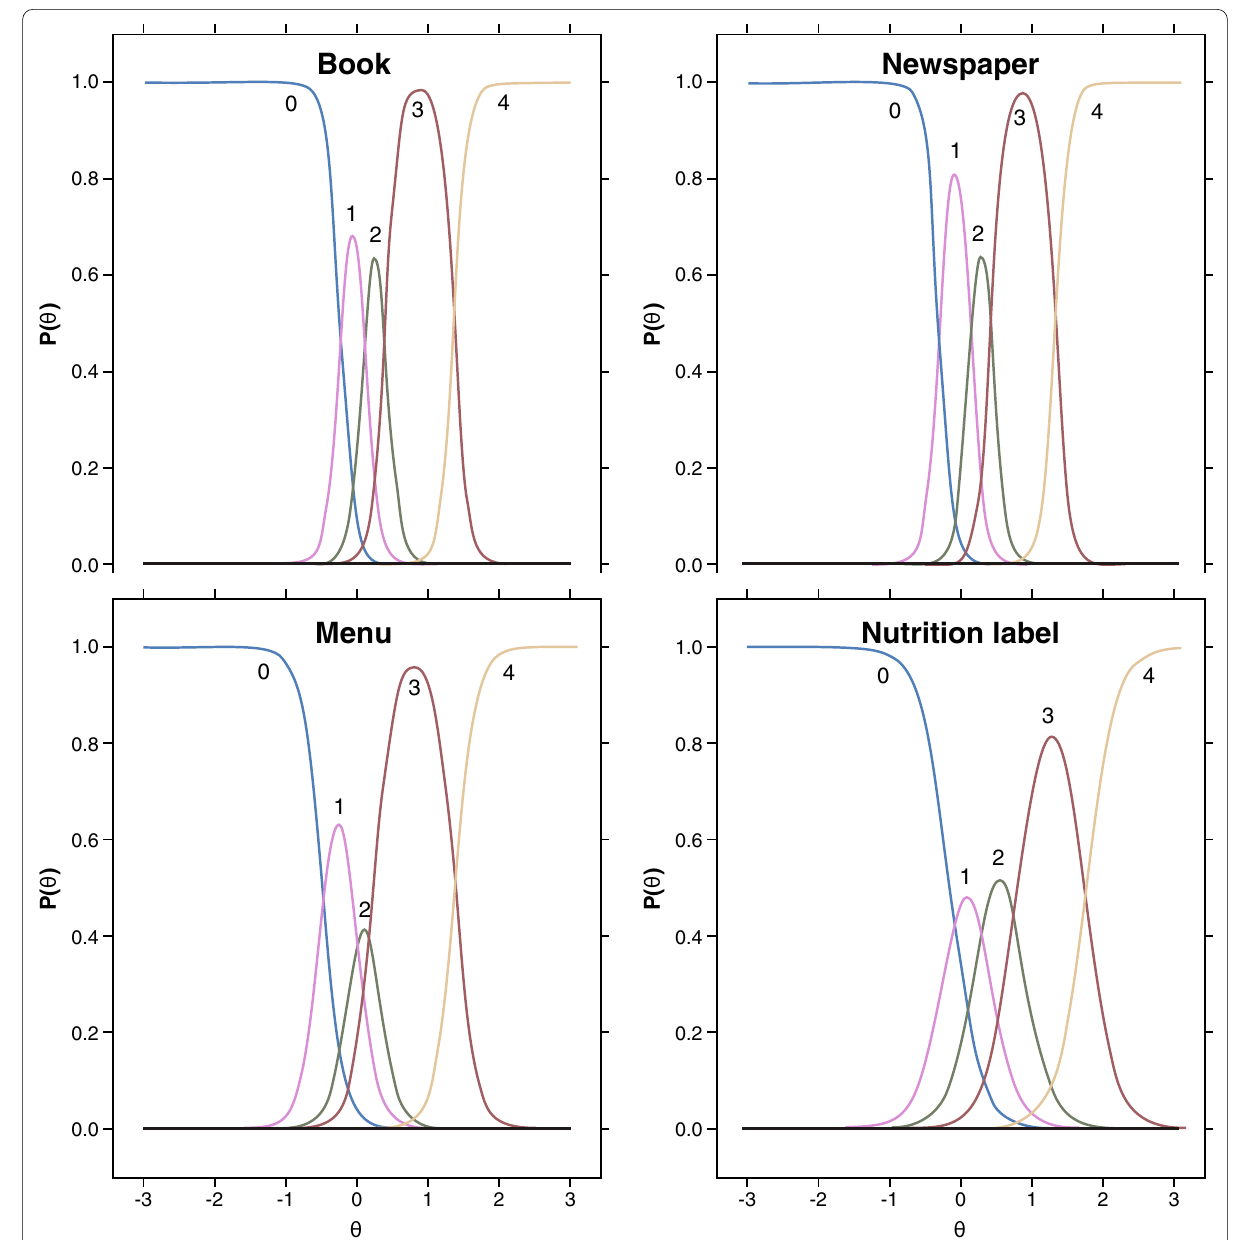
Fig. 4 Graded item characteristic curves for the Satisfaction correspond to the testlet responses as defined in Table